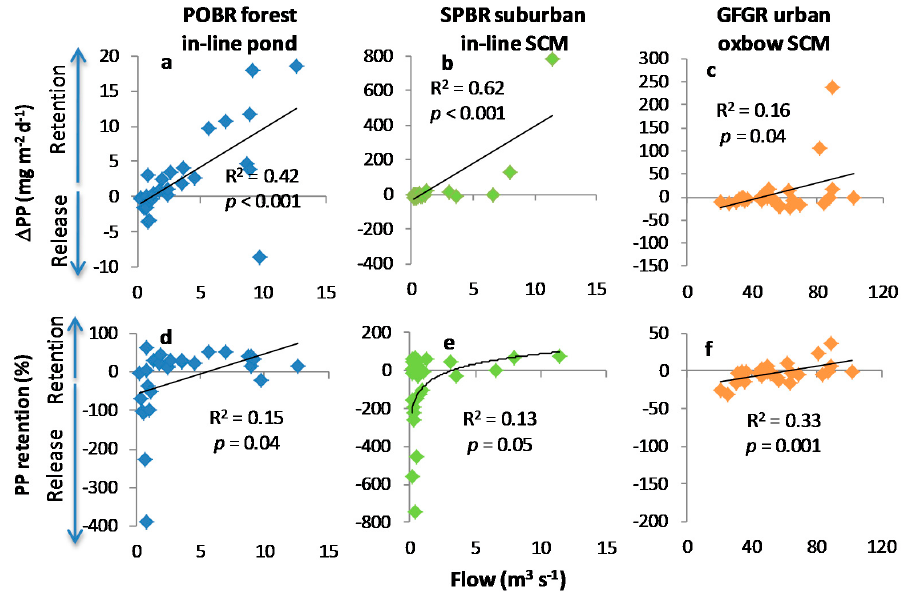
Figure 4. Changes in ( a – c ) areal retention rates and ( d – f ) retention efficiency of particulate phosphorus (PP) ( ∆ PP/total PP input × 100%) with increasing stream flow in the forest pond and the suburban/urban SCMs.